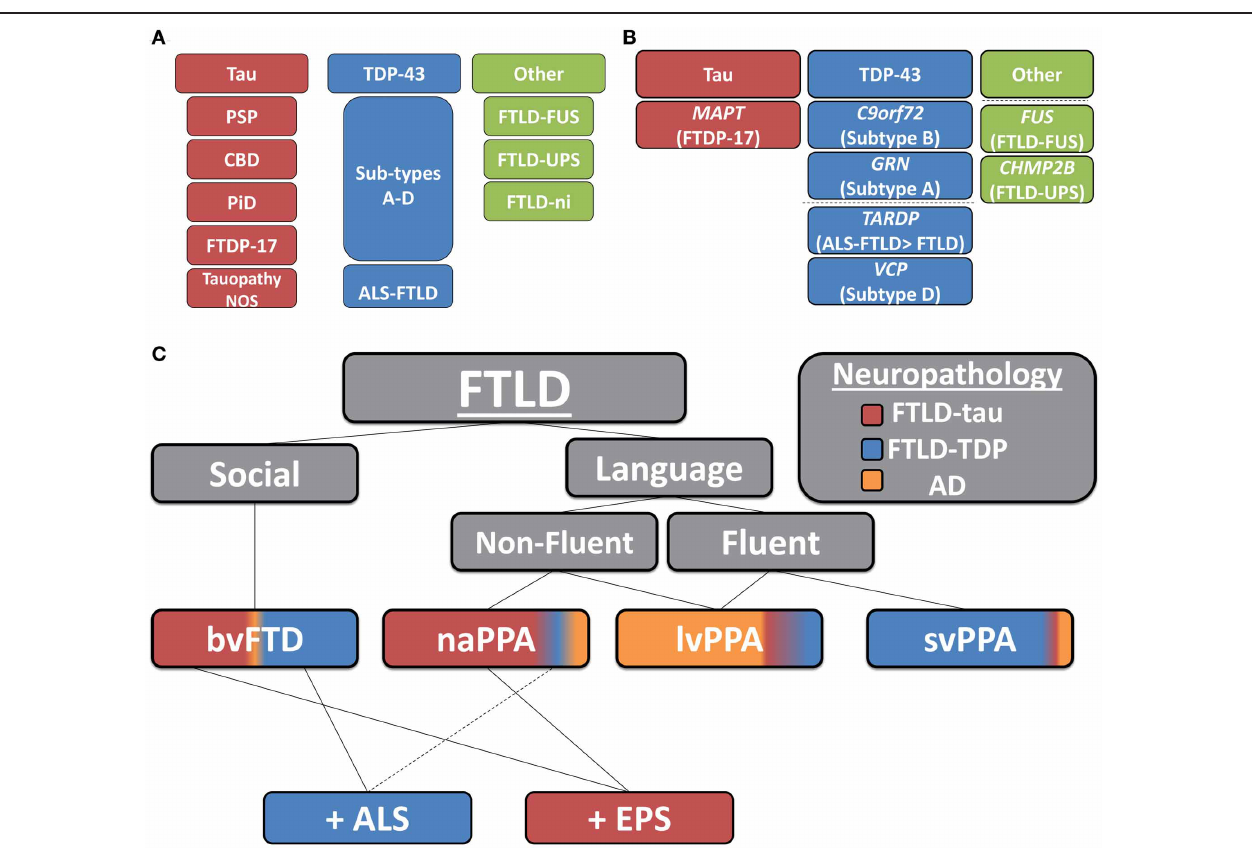
progranulin resulting in FTLD-TDP type A; TARDP , TDP-43 resulting in ALS ± FTLD and less commonly FTLD; VCP , valosin-containing protein resulting in inclusion body myopathy with Paget’s disease of bone and frontotemporal dementia with FTLD-TDP subtype D; FUS , fused-in sarcoma protein resulting in FTLD-FUS; and CHMP2B , charged mutlivesciular body protein 2B resulting in FTLD-UPS), (C) clinicopathological correlations of FTLD (colored regions of clinical syndromes represent relative percentages of neuropathological subtypes found in autopsy studies; AD, Alzheimer’s disease; bvFTD, behavioral variant of FTLD; PPA, primary progressive aphasia; svPPA, semantic variant PPA; naPPA, nonfluent agrammatic variant PPA; lvPPA, logopenic variant PPA; + ALS, co-morbid amyotrophic lateral sclerosis; + EPS, co-morbid extra-pyramidal Parkinsonian symptoms: i.e., features of akinetic-rigid syndromes of PSP or corticobasal